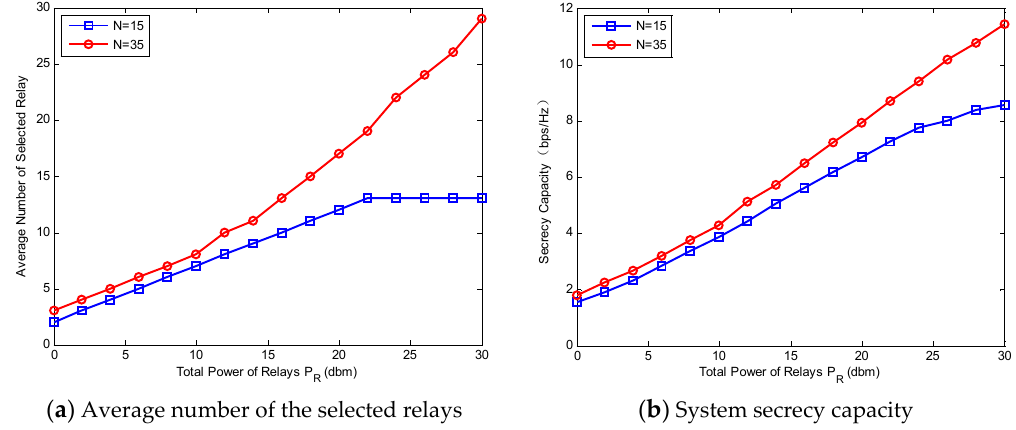
Figure 5. System performance and the average size of coalition versus power of relay 𝑃 (cid:3019) .